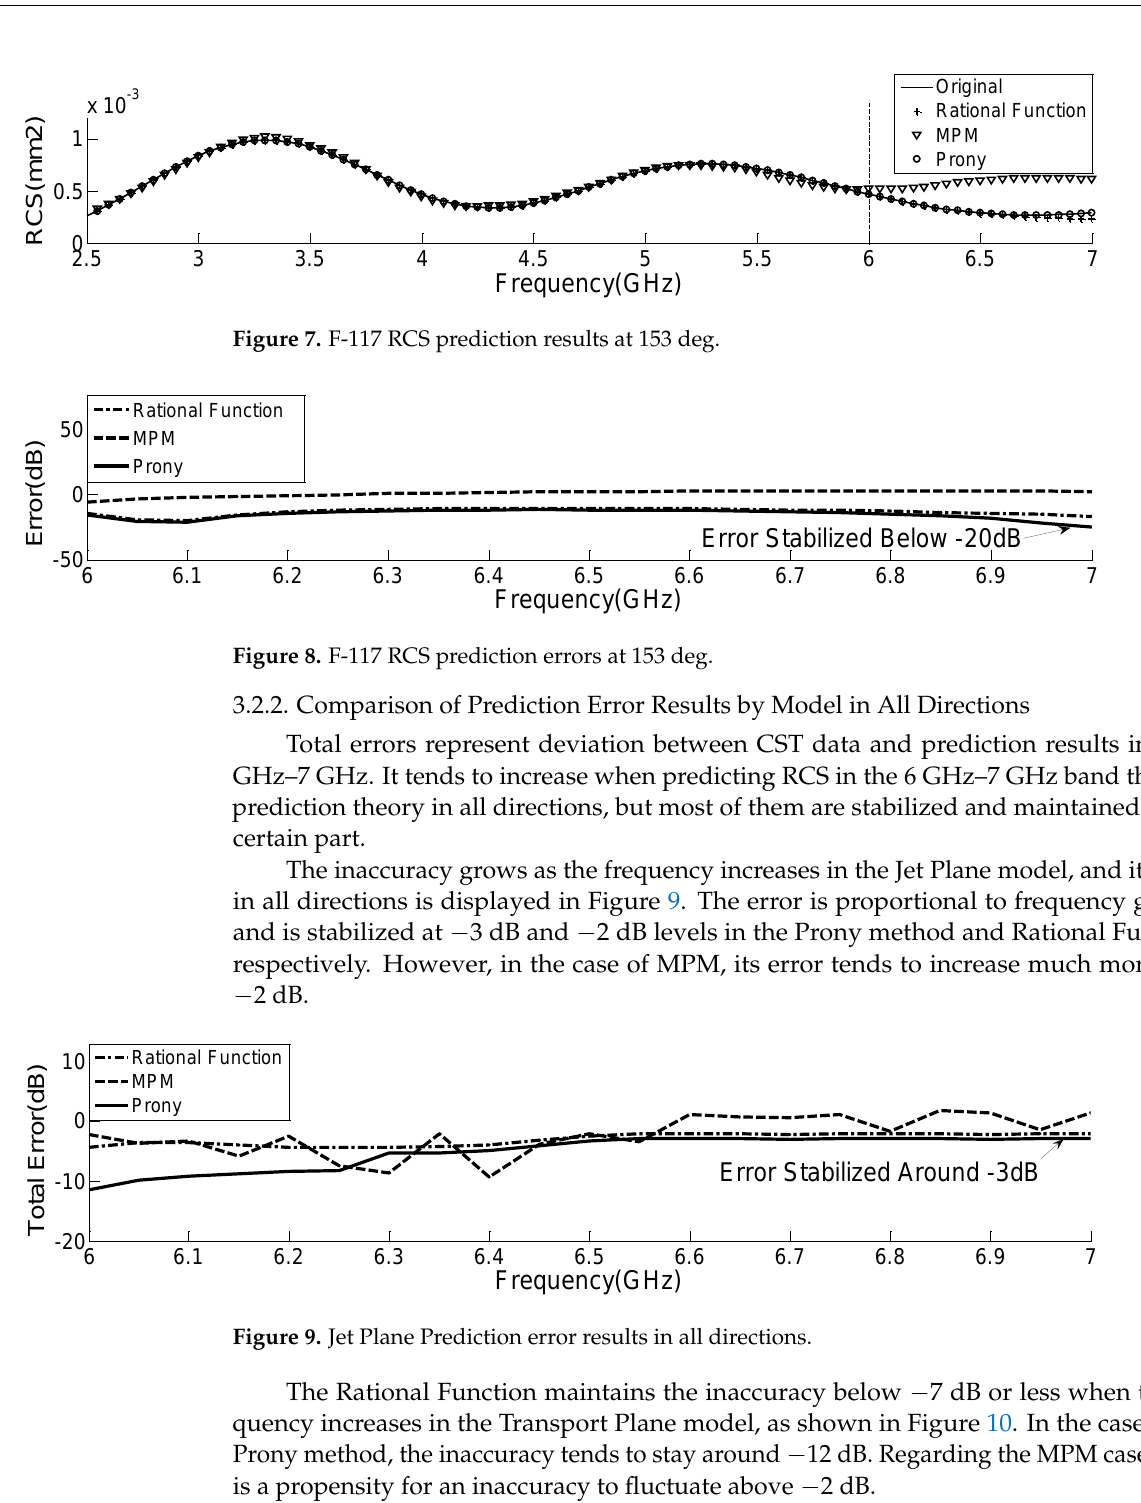
Figure 10. Transport Plane Prediction error results in all directions.